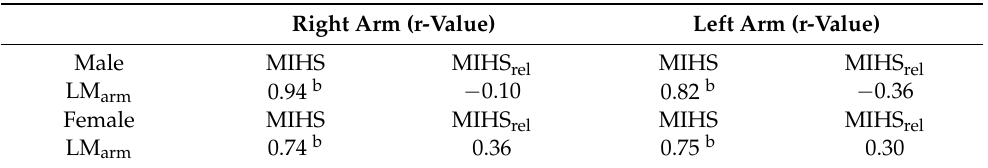
Table 3. Correlation between lean mass and maximum isometric and relative handgrip strength of